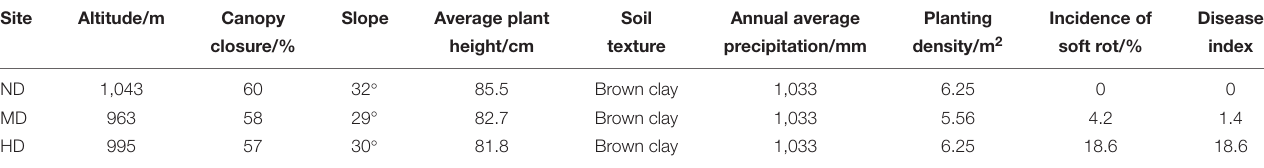
TABLE 1 | Profile of three konjac growing sites in the study.